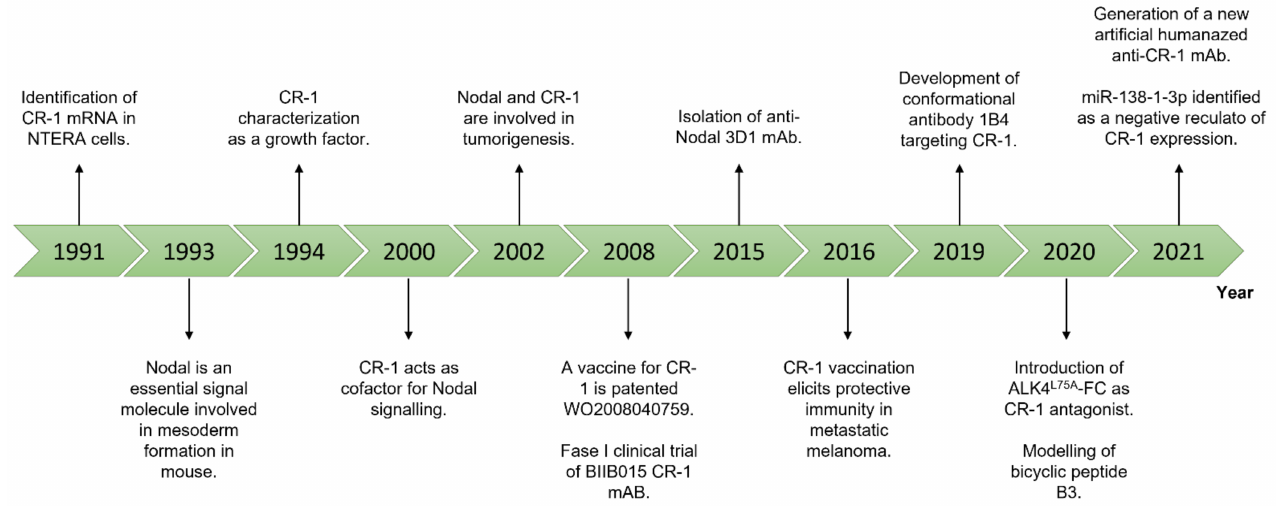
Figure 2. Timeline of the most relevant findings about Nodal and